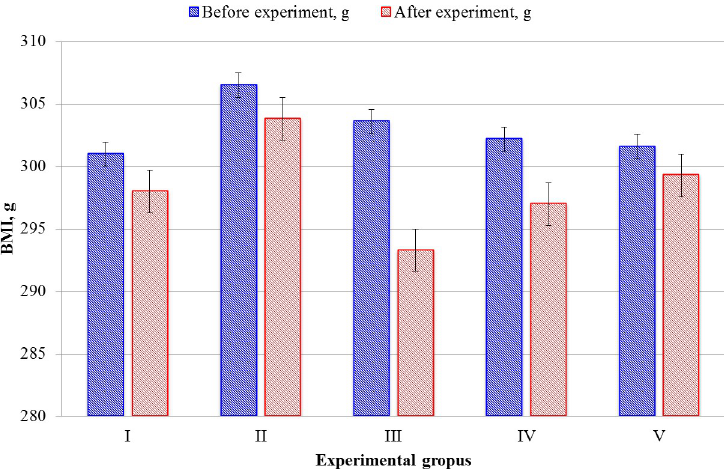
Fig 2. Comparing the product effect on changes in body weight of all groups before and after feeding, g. Data represent Mean ± SD. � Mean difference is significant at ( α � 0.05) compared to the first day as determined by software at the end of the experiment. ANOVA’s P-value is 0.53, Qs is lower critical values associated with the Studentized Range Distribution Qa– 5.673, and SE is 2.78.